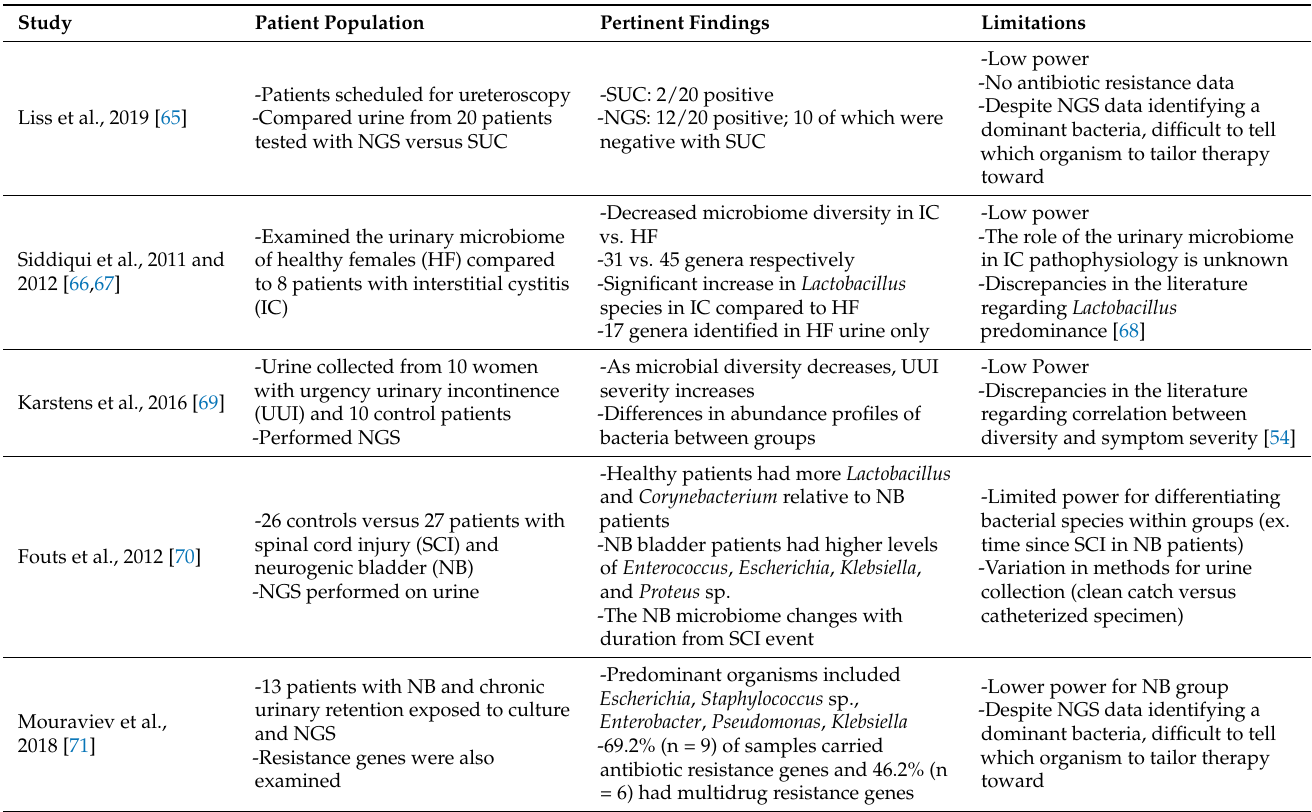
Table A1. Multifactorial applications amongst urologic patients for NGS in UTI diagnostics.